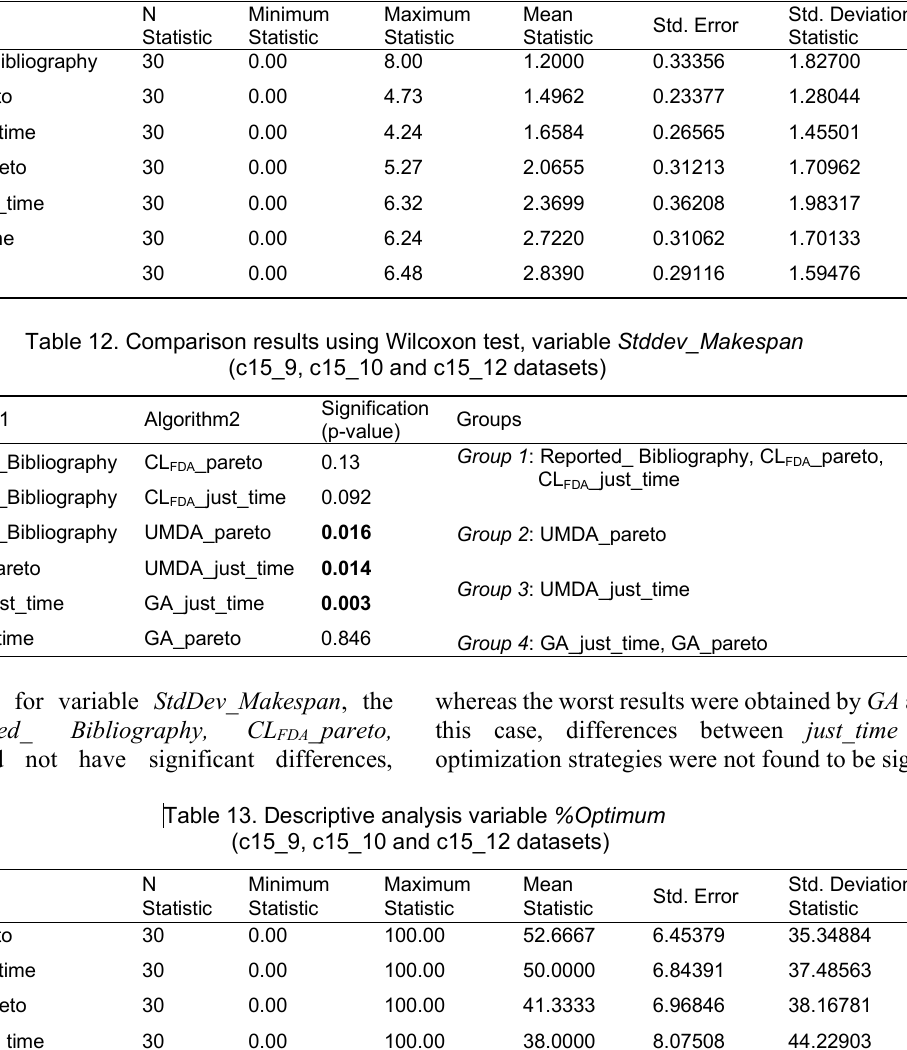
Table 11. Descriptive analysis, variable StdDev_Makespan (c15_9, c15_10 and c15_12 datasets)